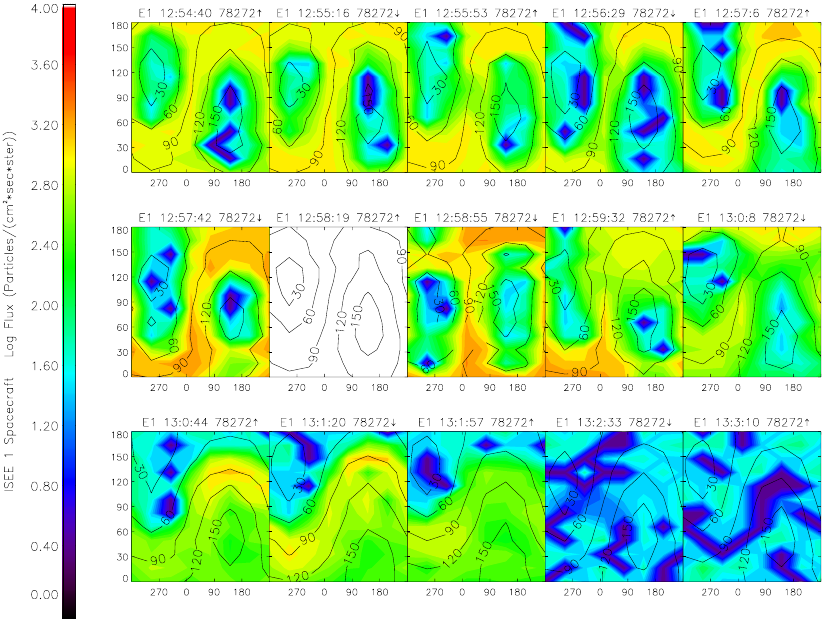
Fig. 7. Electron flux presented similar to Fig. 4, but for the time period 12:54:40–13:03:10 UT. The three panels on the left side of the bottom row show a region where electrons are flowing from beneath the spacecraft just before it leaves the CDC. The third panel in this row is the end of zone 4.